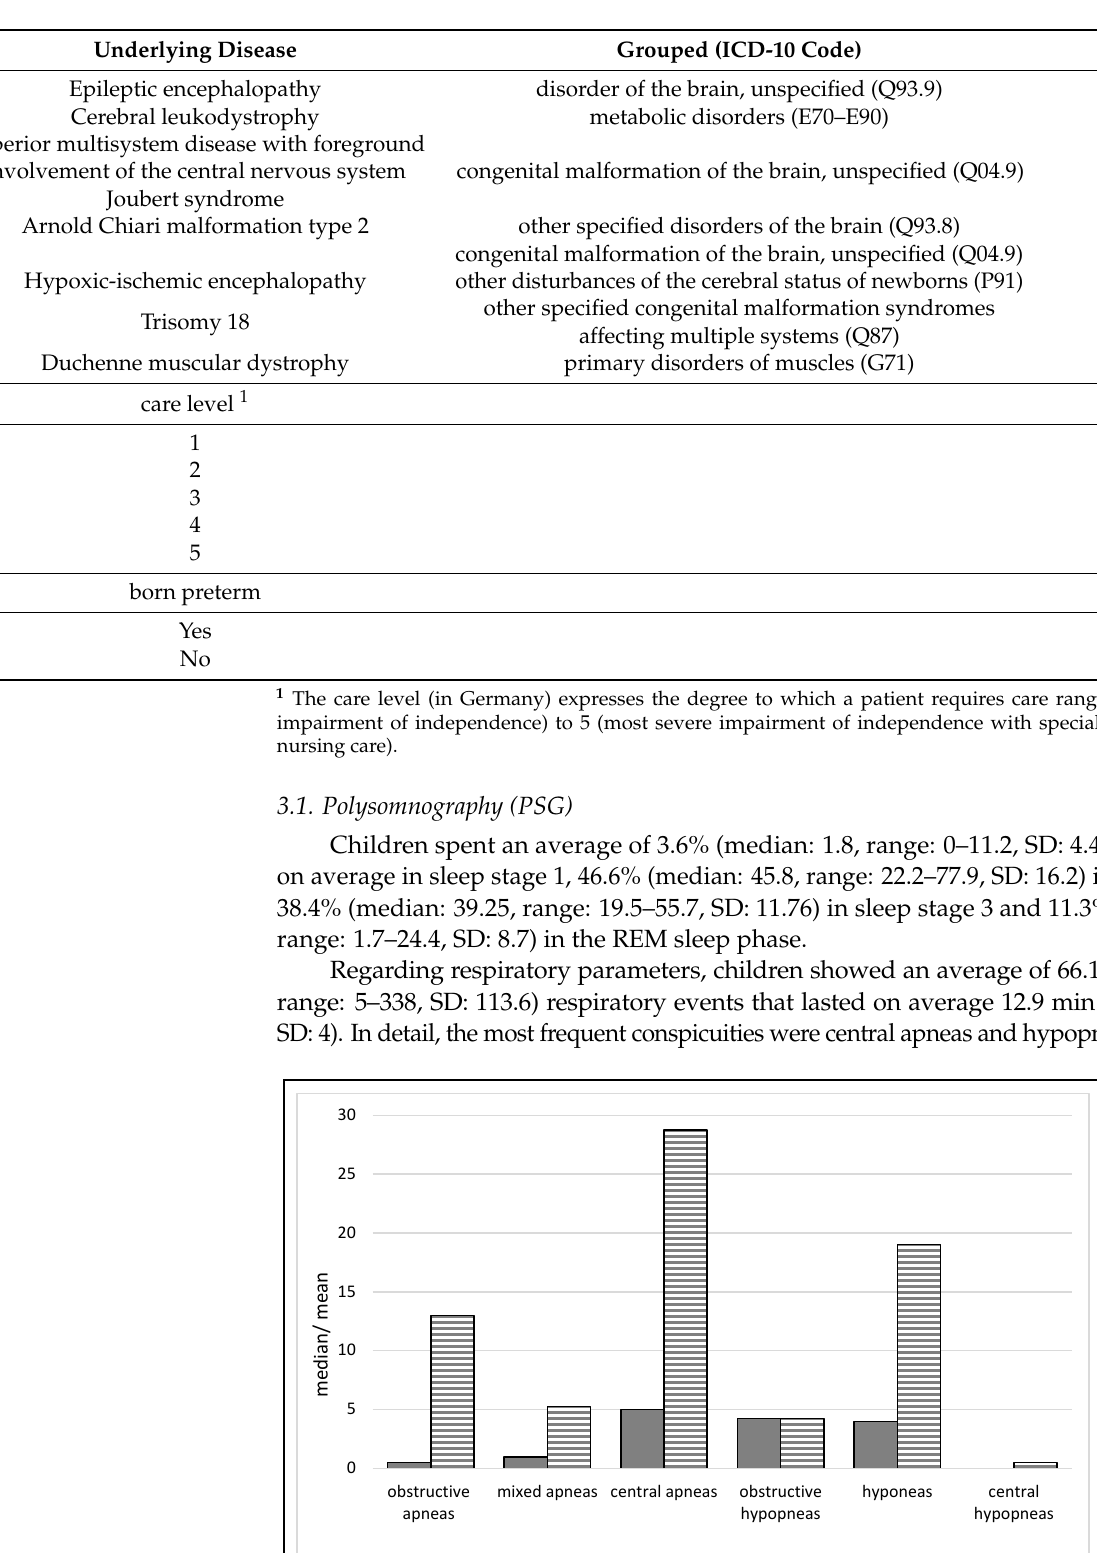
Table 1. Patient characteristics.